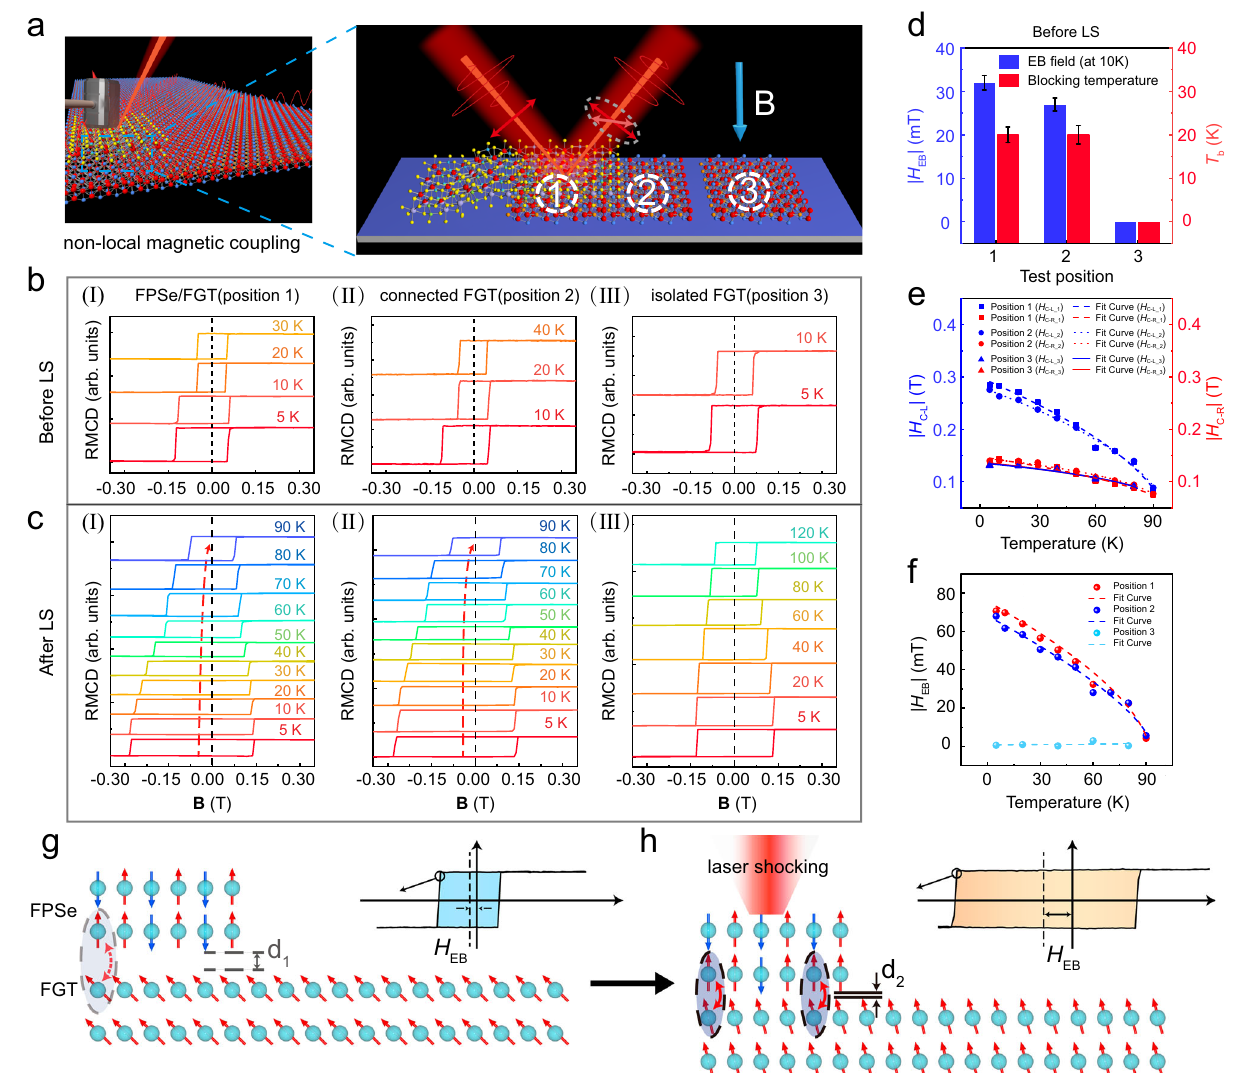
Fig. 4 | Non-local effects of EB. a The schematic diagram of the magneto-optical Kerr test for sample B, where position 1, 2, and 3 represents FGT/FPSe, connected FGT, and isolated FGT. b The measured EB fi eld for FPSe/FGT at position 1 (I), connected FGT at position 2 (II), and isolated FGT at position 3 (III) before LS, respectively. c ThemeasuredEB fi eld forFPSe/FGTatposition1(I),connectedFGT at position 2 (II), and isolated FGT at position 3 (III) after LS, respectively. d A comparison of H EB and T b at the three positions corresponds to ( b ). Error bars represent standard deviation for several consecutive measurements. e A detailed comparisonof H C-L and H C-R versusthetemperatureofFPSe/FGTheterostructures,